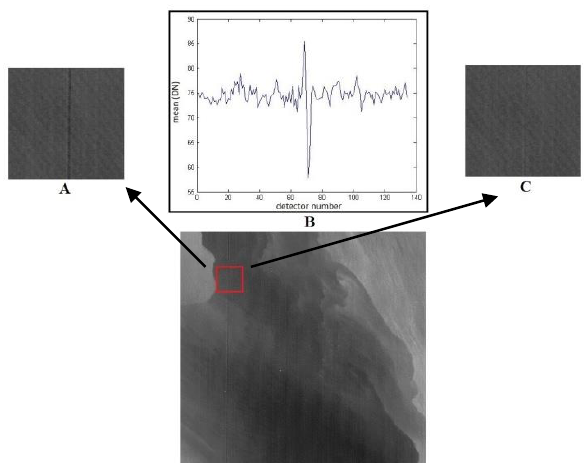
Figure 5. The image acquired in band 2 of CBERS 2 CCD Camera. A) A part of the original image. B) The variation of the columns mean. C) Modified image